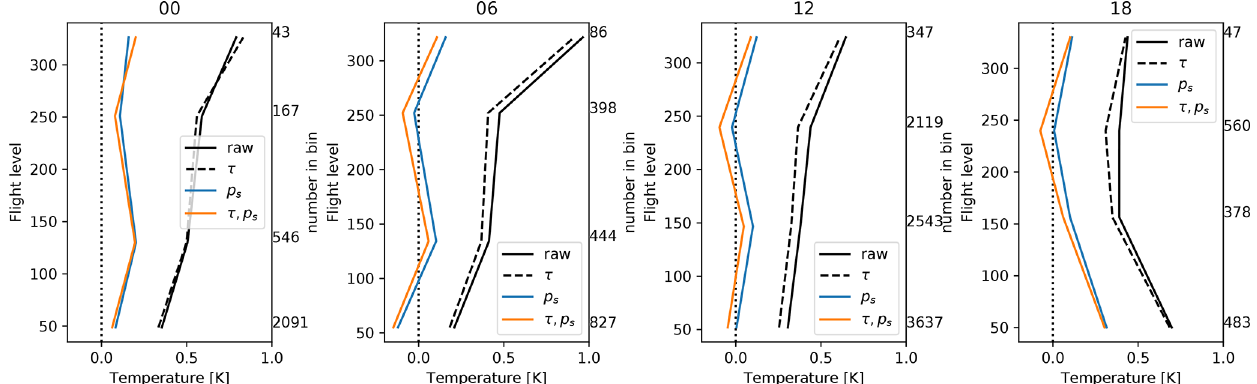
Figure 3. Mean of AMDAR temperature minus radiosonde temperature, subdivided into 4 synoptic hours.